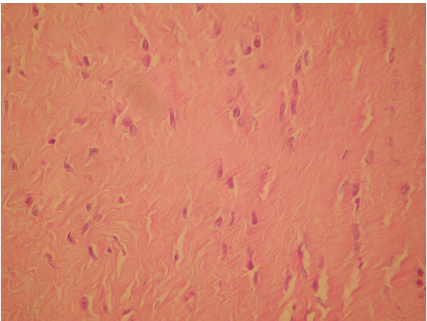
Figure 2: Pathological examination shows fibromatosis (Hematox- ylin-Eosin,